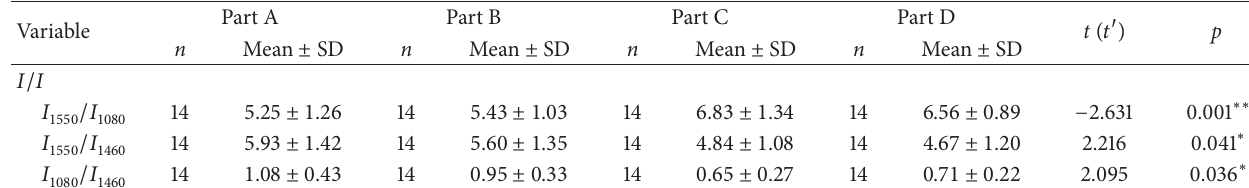
Table 2: FTIR spectrum comparisons of Parts A, B, C, and D ( t -test results).